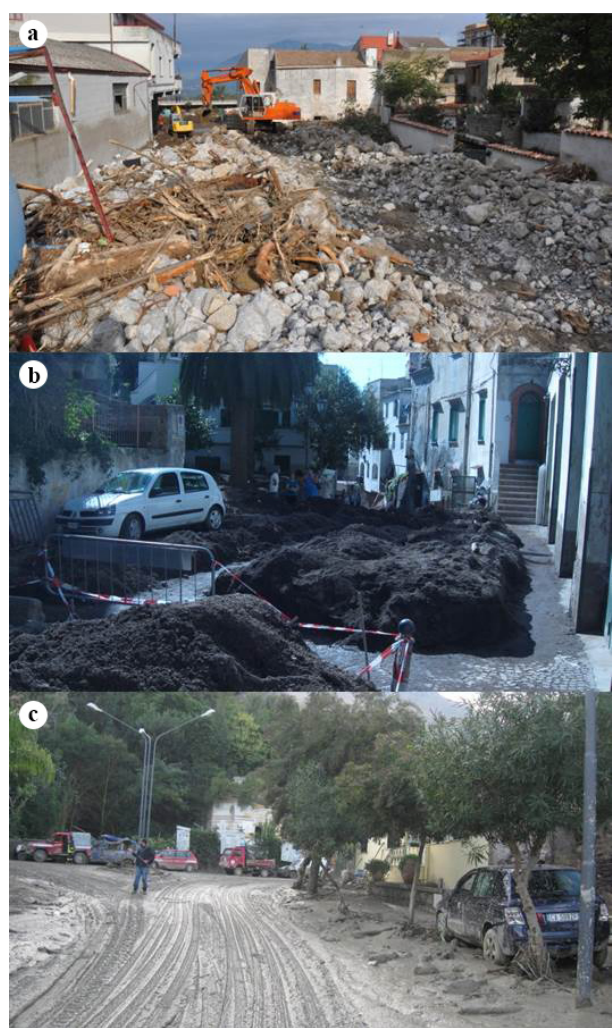
Figure 11. Different grain size deposits for the different catchment classes: (a) Solopaca 2015, carbonate gravels and blocks (class 2); (b) Atrani 2010, gravel and sands (classes 1 and 3); (c) Casamicci- ola 2009: sands, silt and clay (classes 4 and 5).